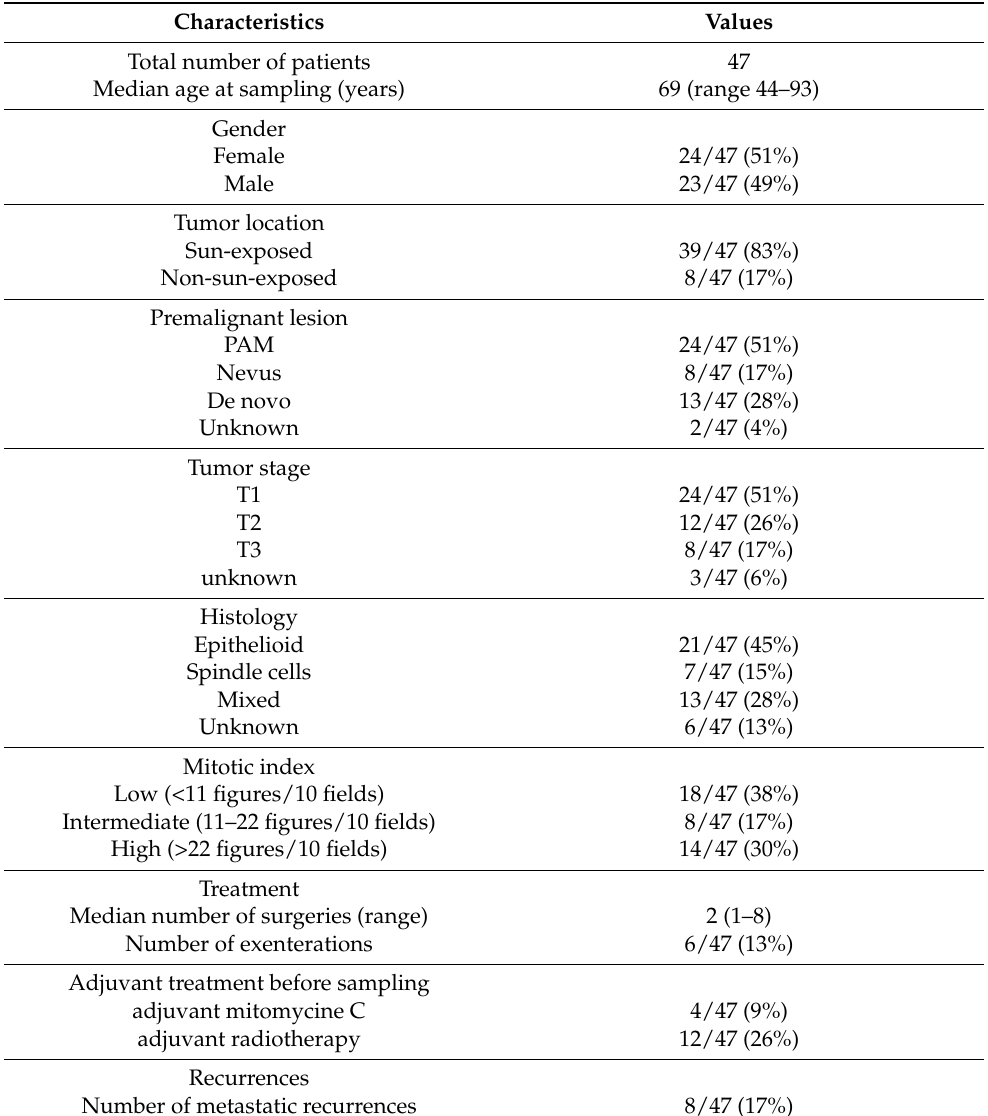
Table 1. Summary of clinical